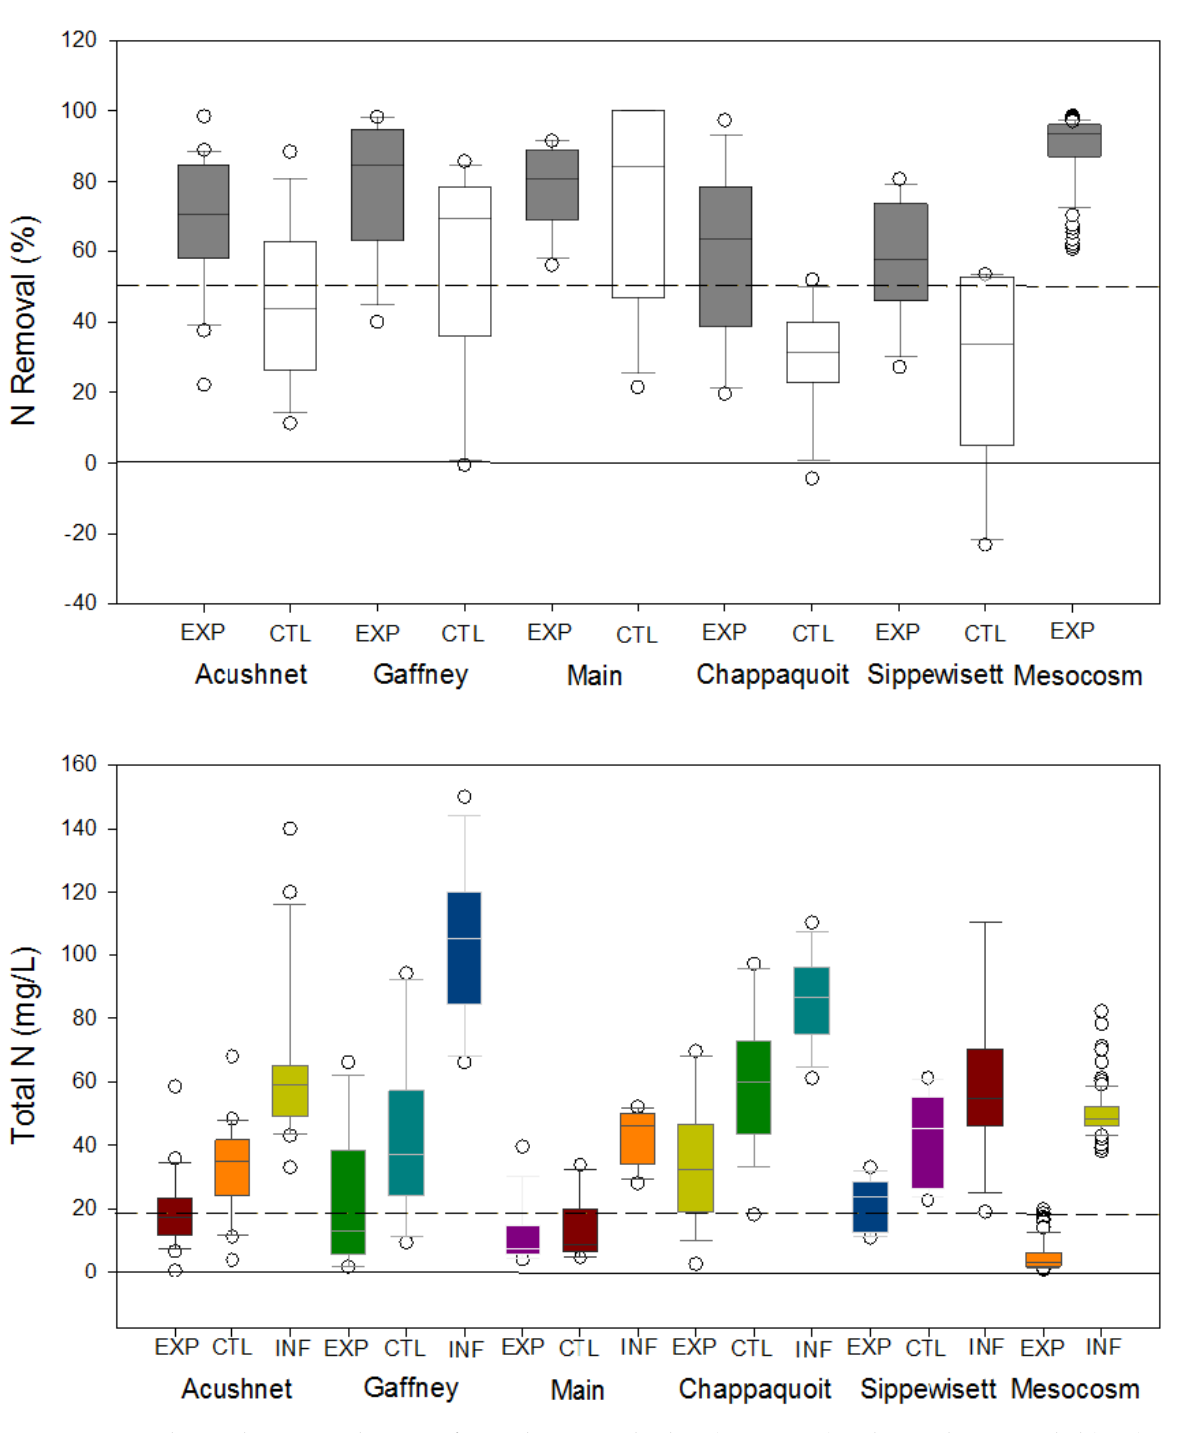
Figure 4. Top : Median and interquartile range of % total N removal values ( n = 13 to 25) in the sawdust–amended (EXP) and unamended (CTL) soil treatment areas (STA) for field systems. Values ( n = 97) for a mesocosm representing an experimental STA are included for comparison. Dashed line indicates 50% TN removal standard. Bottom : Median and interquartile range of total N concentration values ( n = 13 to 25) for in influent (INF; septic tank effluent) and effluent from EXP and CTL STAs for field systems. Values ( n = 96) for a mesocosm representing an experimental STA are included for comparison. Dashed line indicates 19 mg TN/L standard.